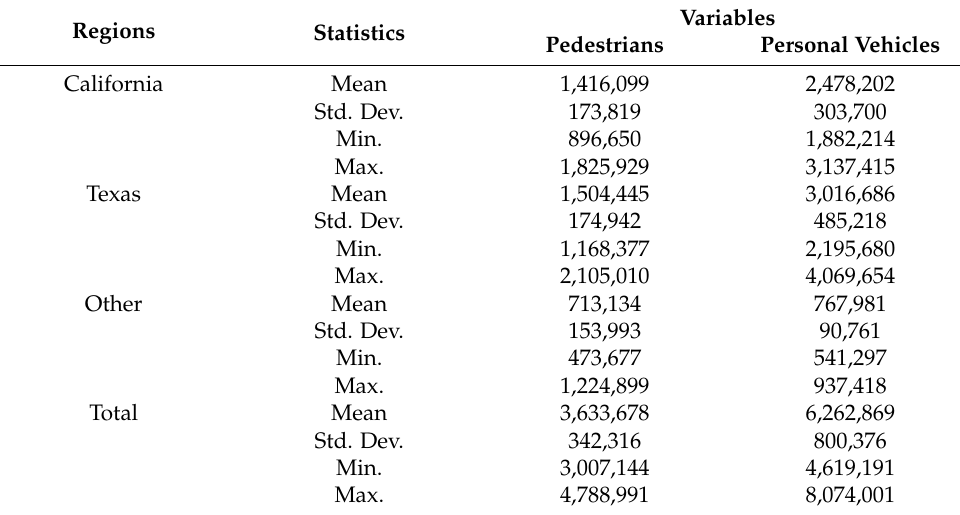
Table 1. Descriptive statistics of pedestrians and personal vehicles crossing the border from Mexico to the U.S.